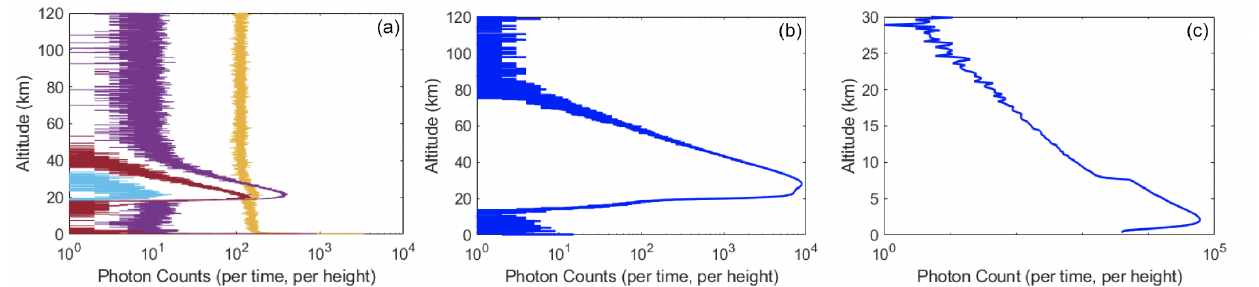
Figure 1. Example of measurements taken by PCL Rayleigh and Raman channels. (a) Examples of bad profiles for both Rayleigh and Raman channels. In this plot, the signals in cyan and dark red have extremely low laser power, the purple signal has extremely high background counts, and the signal in orange has a distorted shape and high background counts. (b) Example of a good scan in the Rayleigh channel. (c) Example of cloudy sky in the nitrogen (Raman) channel. At about 8km a layer of either cloud or aerosol